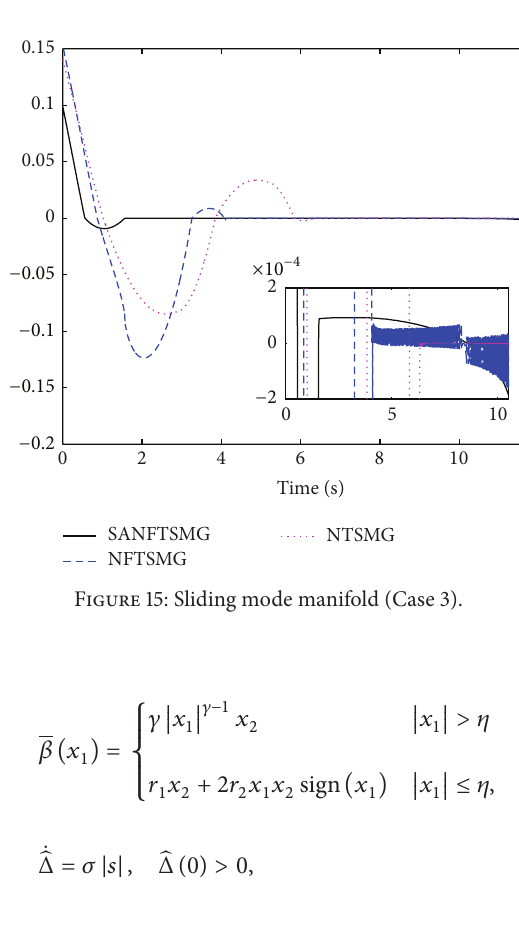
Figure 14: LOS angular rate (Case 3).